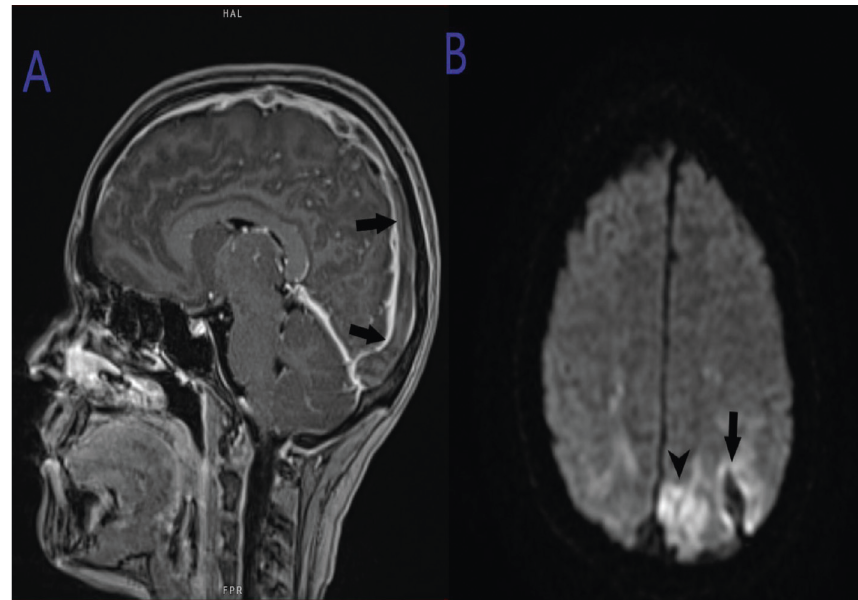
Figure 1: Magnetic resonance imaging (MRI) of the brain with contrast. (a) Postcontrast sagittal view showing extensive filling defect in the superior sagittal sinus consistent with thrombosis. (b) Diffusion weighted imaging (DWI) coronal view demonstrating left parietal lobe infarct (arrow) and hemorrhage (arrowhead).